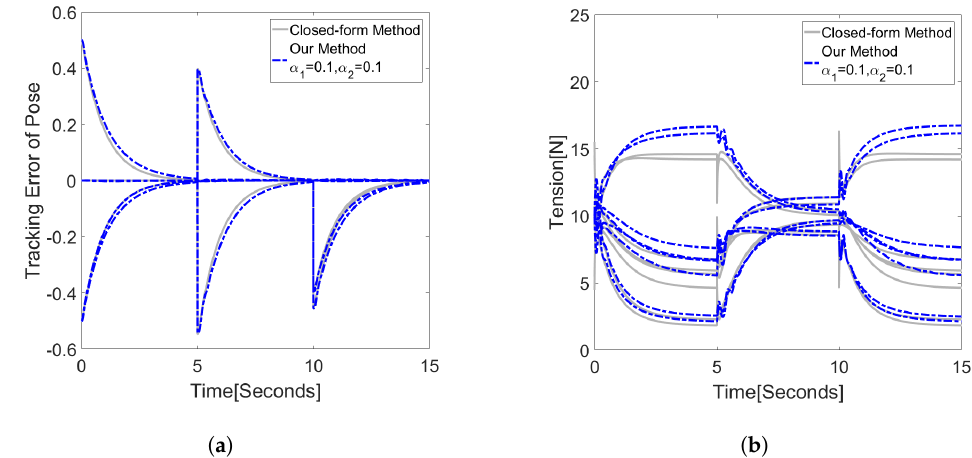
Figure 8. Comparison of our method and closed-form method (shifting desired pose). Parameters and desired pose are selected as α 1 = 0.1, α 2 = 0.1, K d = 2, D d = 1, K i = 0, q d = [ 0.5, − 0.5,0.5,0,0,0 ] T ( 0 s → 5 s ) , q d = [ 0.1,0.05,0.5,0,0,0 ] T ( 5 s → 10 s ) and q d = [ 0.5,0.5,0.5,0,0,0 ] T ( 10 s → 15 s ) . ( a ) Tracking error of pose. ( b ) Tension